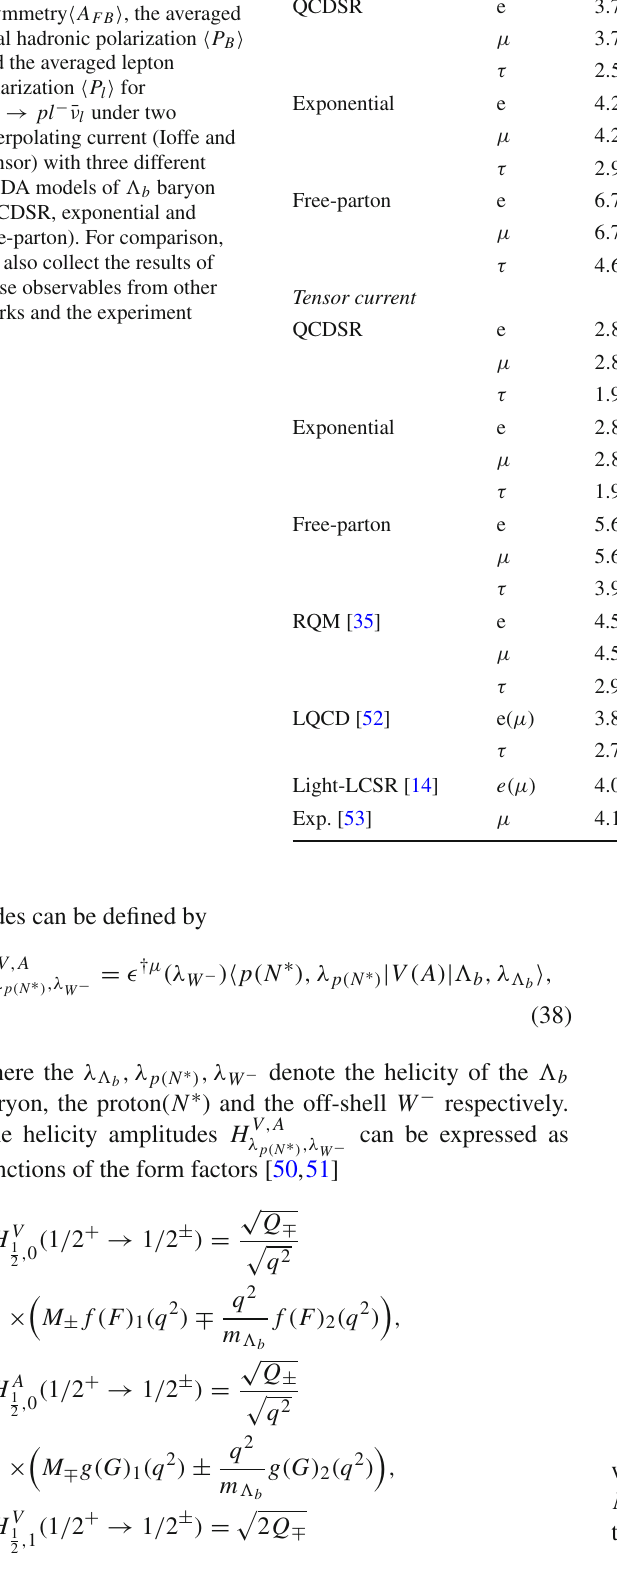
Table 5 The predictions for the branching fractions, the averaged leptonic forward-backward asymmetry (cid:6) A FB (cid:7) , the averaged final hadronic polarization (cid:6) P B (cid:7) and the averaged lepton polarization (cid:6) P l (cid:7) for (cid:2) → pl − ¯ ν b l under two interpolating current (Ioffe and Tensor) with three different LCDA models of (cid:2) b baryon (QCDSR, exponential and free-parton). For comparison, we also collect the results of these observables from other works and the experiment